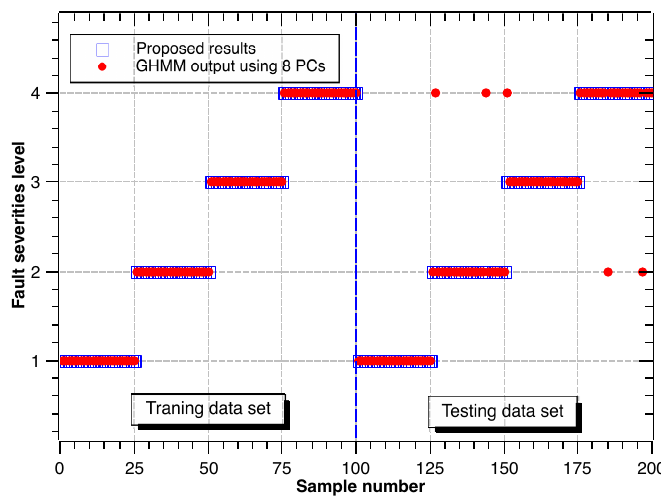
Figure 10. Classification results of fault severity levels under ball defect.